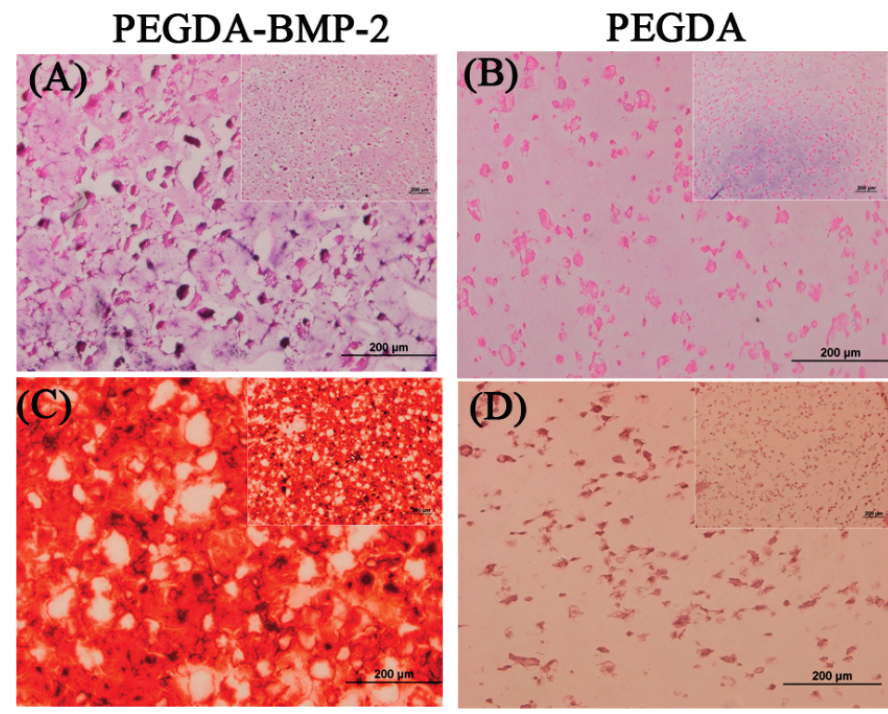
Figure 9. Representative H&E stain ( A , B ), Alizarin red stain ( C , D ) of PEGDA-BMP-2 ( A , C ), and PEGDA ( B , D ) photo-responsive hydrogels containing LFs after 12-week transplantation. Scale bar = 200 μ